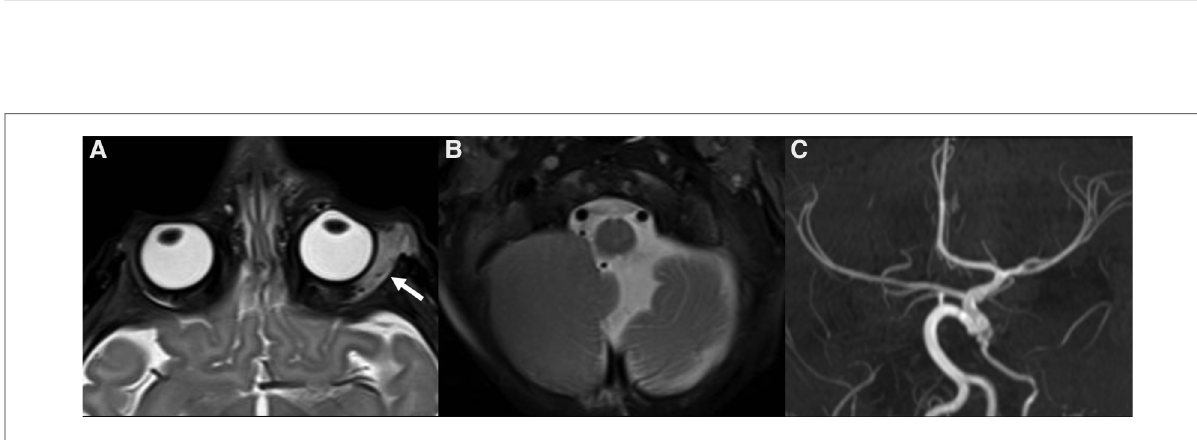
FIGURE 6 MRI of 4-month-old girl with a red mass of the left orbit. Axial T2 weighted images ( A,B ) show a left orbital hyperintense mass (big white arrow in A ) with tiny fl ow-voids involving the extra and intraconal compartments, consistent with infantile hemangioma (IH); on the same sequence the cerebellar atrophy on the ipsilateral side of the IH is also noted ( B ). Additionally, MR TOF-3D disclosed abnormalities of the intracranial circulation ( C ). The diagnosis of PHACES was fi nally